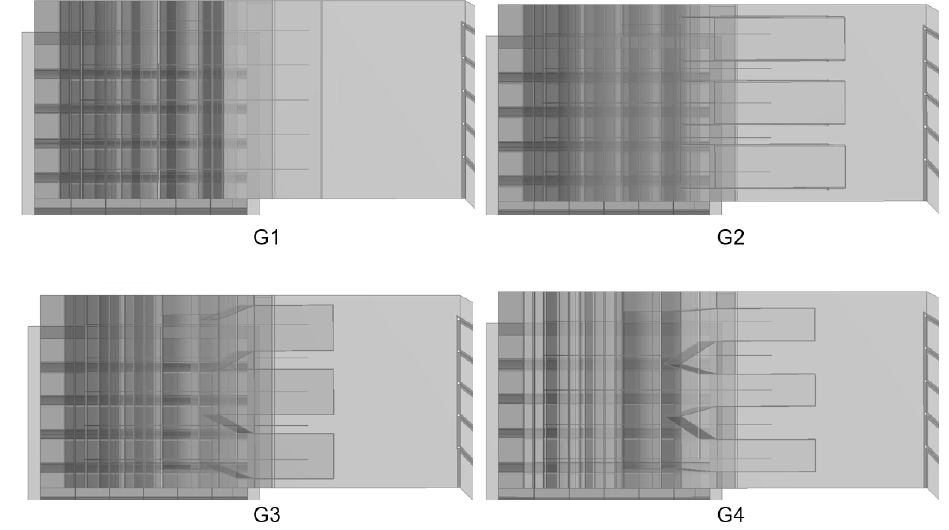
Figure 4. The four geometric variants seen from above, numbered from G1 to G4.